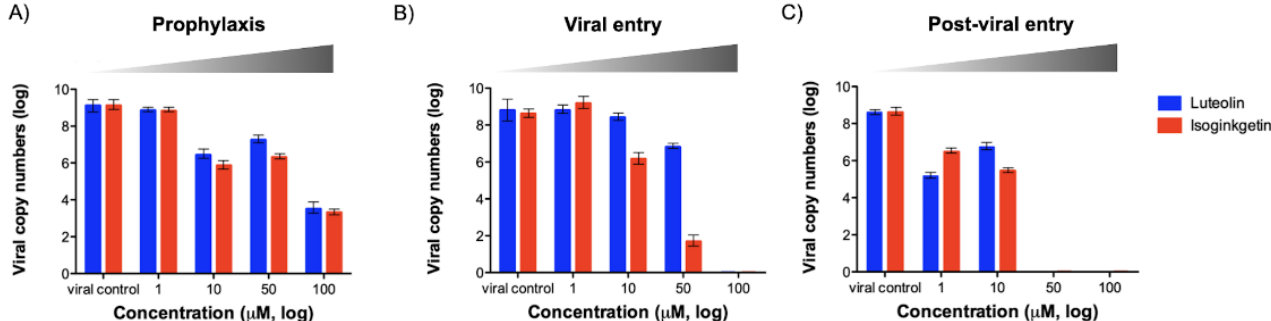
Figure 3. Dose-dependent inhibition of luteolin and isoginkgetin on FMDV replication as examined by RT-qPCR. The antiviral activities of each compound were determined by the reduction of viral copy numbers in the FMDV-infected cells compared to that of the virus control with 1% DMSO (non-inhibitor control). Prophylaxis ( A ), viral entry ( B ), and post-viral entry ( C ) experiments were designed as shown in Figure 1A. The data are reported as means and SD of viral copy numbers from triplicate experiments.